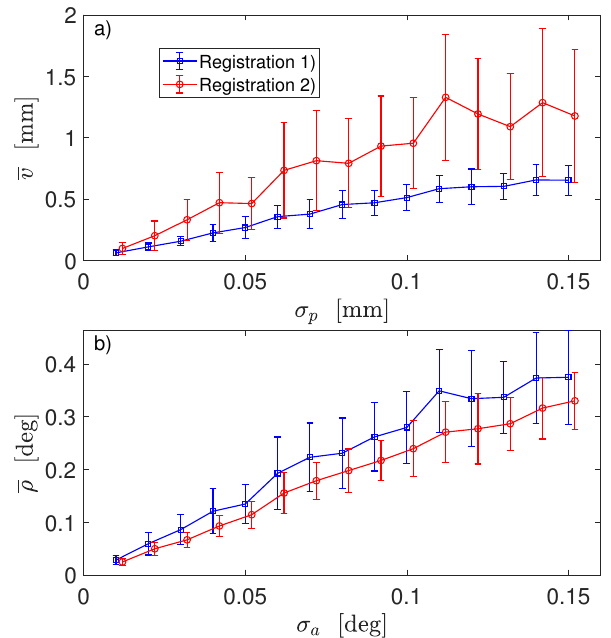
Figure 4. Comparison of two registration procedures for robot calibrated with Method 3 and data generated using large deviations from the default DH parameters: ( a ) dependence of the mean positional error v of robot end-effector on positional noise σ p in sensor 6D data; ( b ) dependence of the mean orientation error ρ of robot end-effector on angular noise σ a in sensor 6D